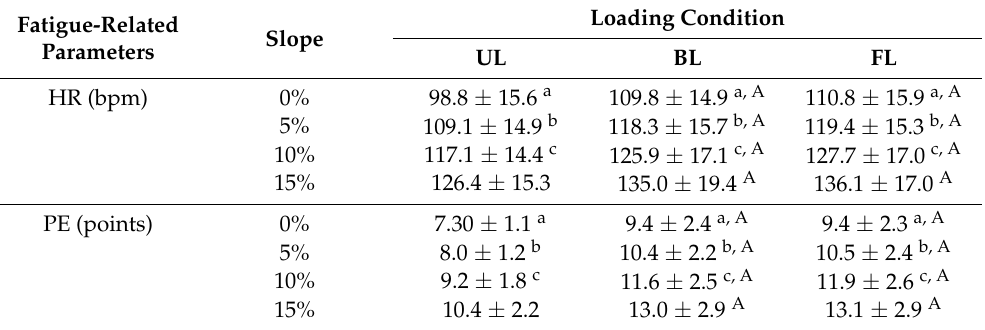
Table 3. Means ± standard deviations of heart rate and perceived exertion during unloaded (UL), back-loaded (BL), and front-loaded (FL) walking at 0 (level), 5, 10, and 15% uphill